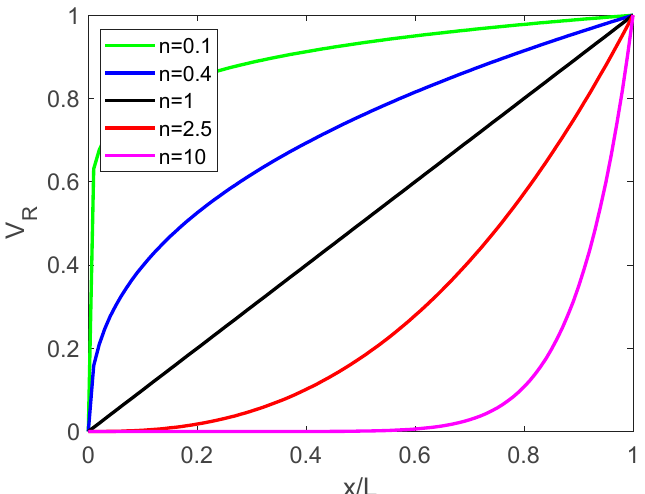
Figure 1. Variation of 𝑉 (cid:3019) throughout the longitudinal direction for various gradient indices The strain energy 𝑈 in Equation (34) can be rewritten for AFG-tapered microbeams as following